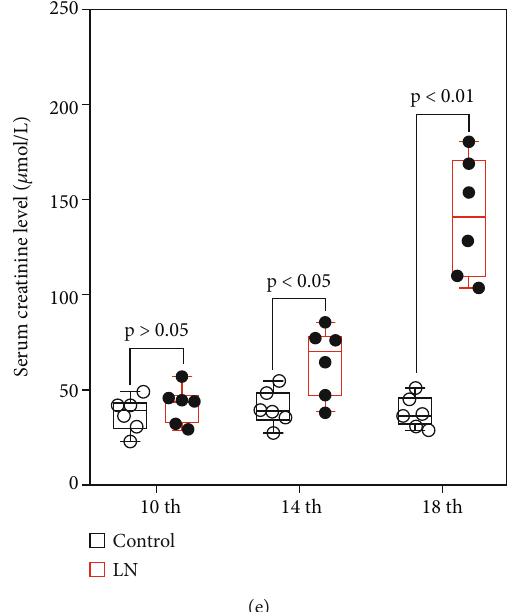
Figure 1: Expression of CEBPB was upregulated in the development of lupus nephritis in MRL/lpr mice. The mRNA expression (a) and protein levels (b) of CEBPB in kidney tissues of MRL/lpr or MRL/MPJ mice at 10th, 14th, and 18th week; 24-hour proteinuria level (c), serum BUN level (d), and serum creatinine level (e) in MRL/lpr or MRL/MPJ mice. (CEBPB, CCAAT/enhancer-binding protein β ; BUN, blood urea